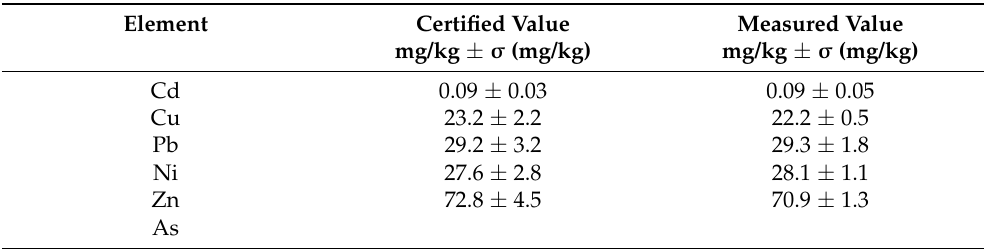
Table 3. Results of pseudo-total metal content (mean ± standard deviation) for certified reference material GBW 07410 after digestion in aqua regia.